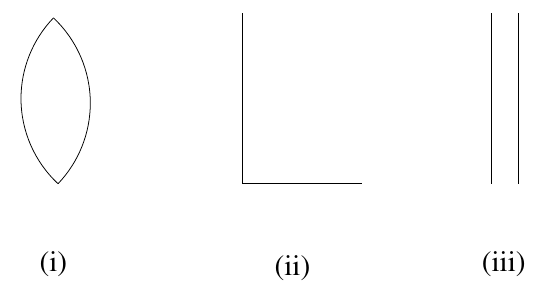
Figure 1 . Skeleton graph for the D 6 R 4 term.